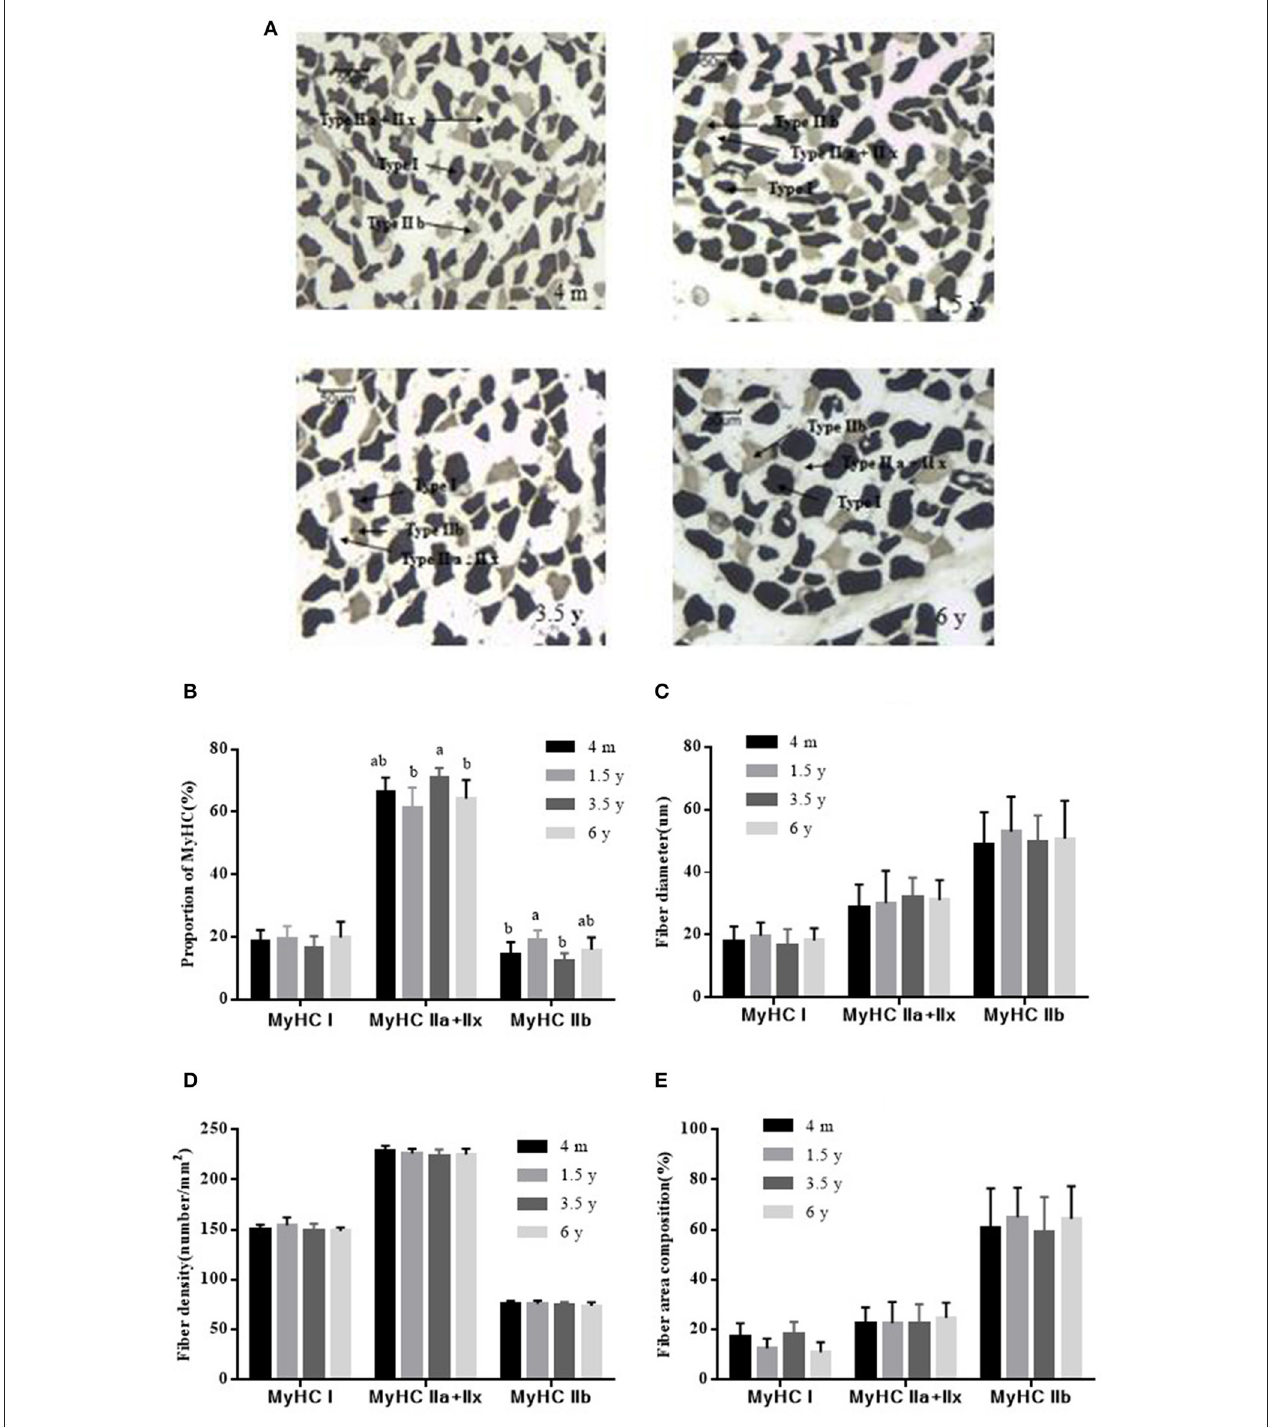
FIGURE 2 | ATPase staining to determine the type of Tibetan sheep muscle fiber ( × 100). (A) Type I fiber was stained dark, the type IIa + IIx fiber was unstained, the type IIb fiber was stained gray. (B) Proportions of MyHC I, MyHC IIa + IIx, and MyHC IIb in the LT muscle of Tibetan sheep at different growth stages. (C) The diameter of MyHC I, MyHC IIa + IIx, and MyHC IIb at different growth stages. (D) Fiber density analysis of MyHC I, MyHC IIa + IIx, and MyHC IIb at different growth stages. (E) Fiber area composition of MyHC I, MyHC IIa + IIx, and MyHC IIb at different growth stages. Data are shown as the means ± S.E. Different letters (a,b) indicate significant between different growth stages ( p <